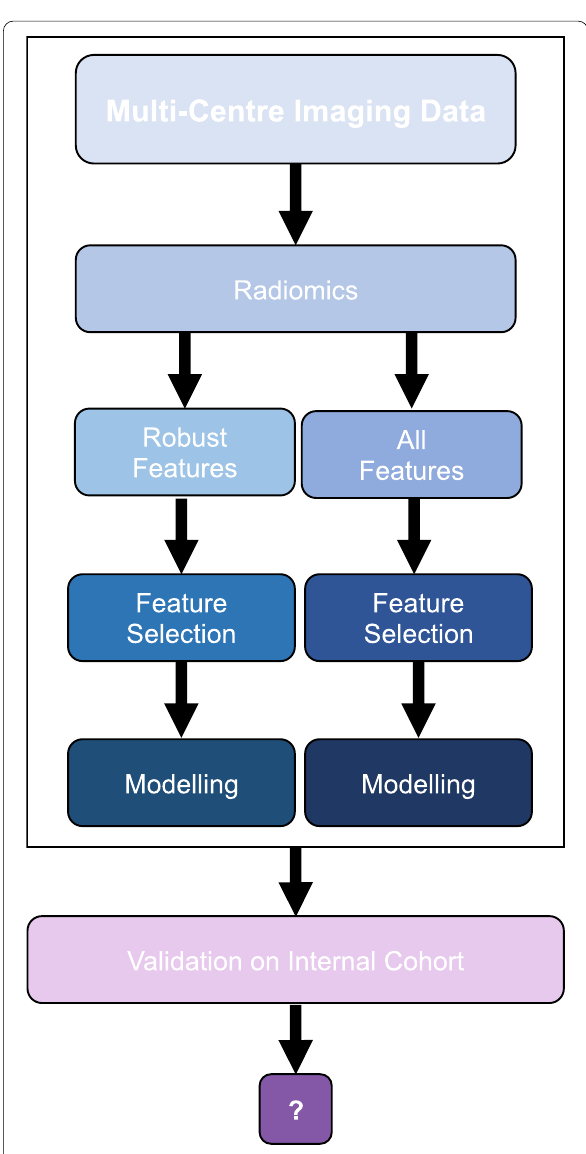
Fig. 1 Workflow. Robust radiomic features (delineation, attenuation correction, 3D vs. 4D acquisition) were identified. Two prognostic models, using robust features only and using all available features, respectively, were constructed for 12‑ and 24‑month event‑free survival (EFS) and overall survival (OS) based on a standardized multi‑centre imaging dataset. Model performance was validated using a separate internal validation